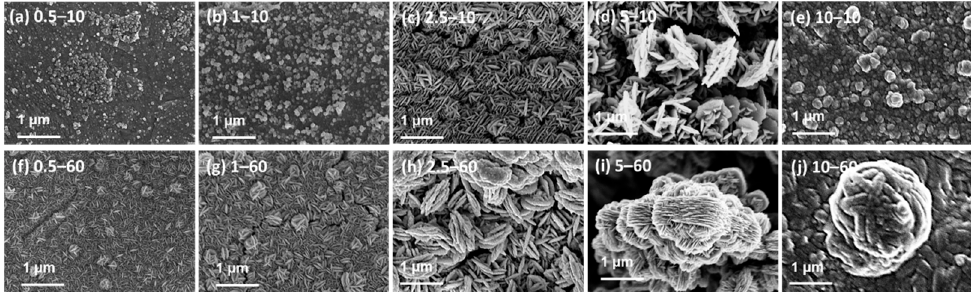
Figure 1. SEM images of the Cu films sulfurized using Na 2 S solution with varying concentrations (c = 0.5–10 mM) for different reaction times of 10 and 60 min; ( a ) 0.5–10, ( b ) 1–10, ( c ) 2.5–10, ( d ) 5–10, ( e ) 10–10, ( f ) 0.5–60, ( g ) 1–60, ( h ) 2.5–60, ( i ) 5–60, and ( j ) 10–60 sample.